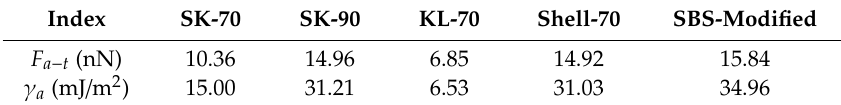
Table 4. The overall surface energies and adhesion forces between the probe and asphalts.